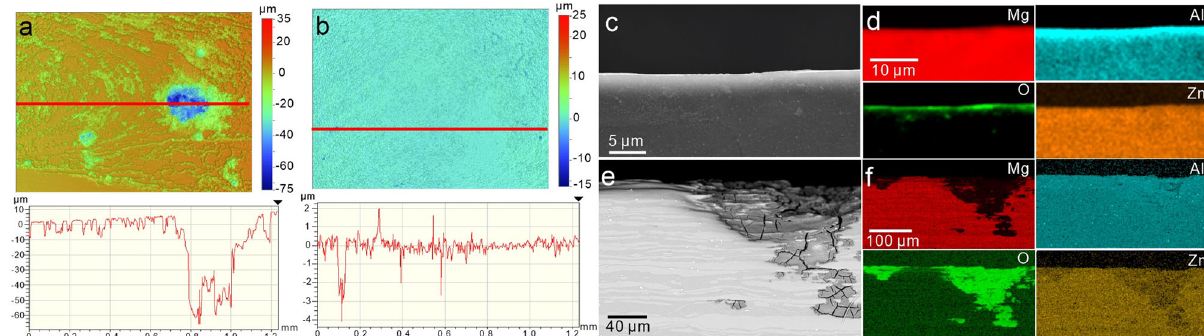
Fig. 2 Surface observation of as-rolled and FSP-aged samples after immersion in 0.1 M NaCl solution for 48 h. a , b Pro fi lometer observation of corroded surface of ( a ) as-rolled and ( b ) FSP-aged sample and ( c – f ) SEM images and corresponding EDS mapping of cross-section showing surface roughness of ( c , d ) FSP-aged and ( e , f ) as-rolled